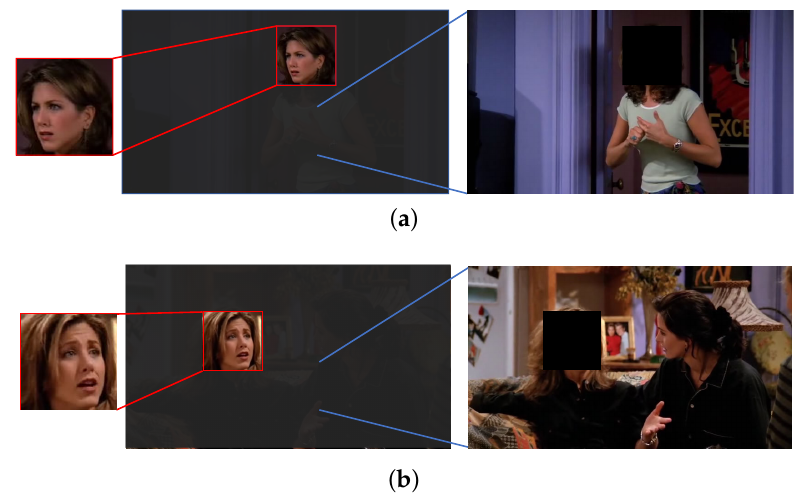
Figure 2. Intuition of emotion understanding: for the images in ( a , b ), the complementary information between facial expressions and context can rectify our understanding of their respective implied emotion information, which enables us to perceive the emotional states more